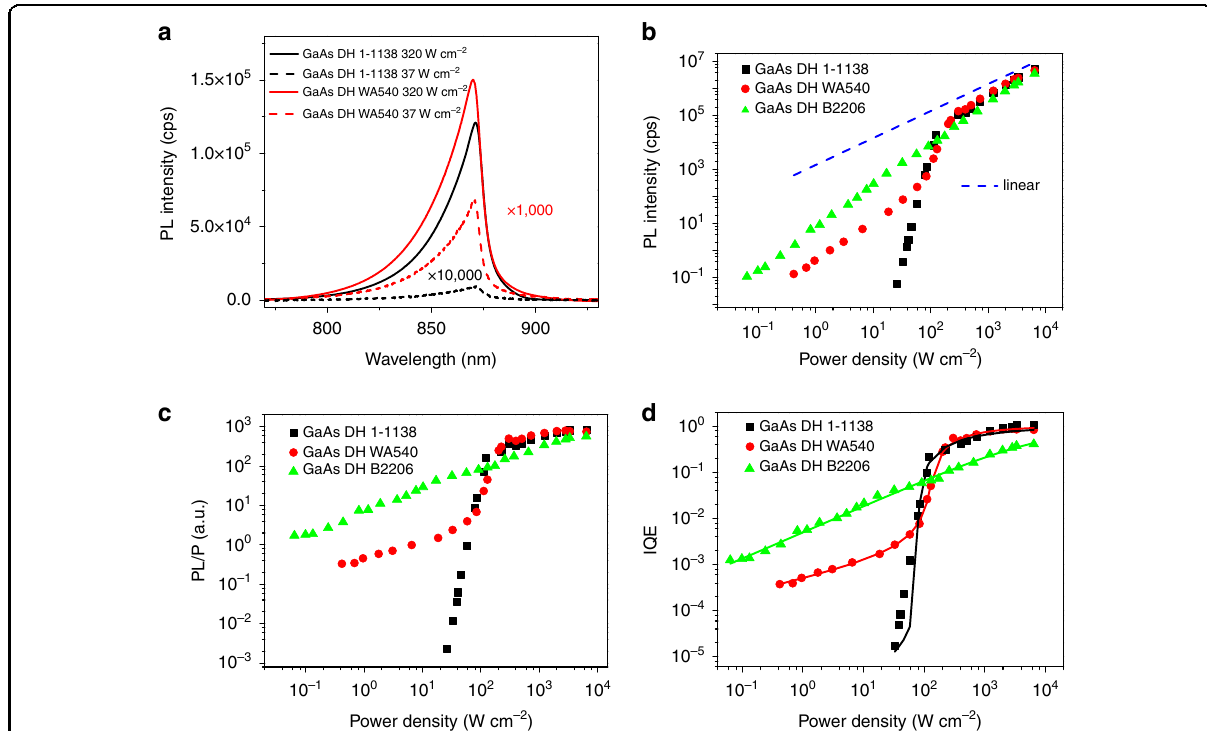
Fig. 2 Excitation power dependent PL data (with 10× lens). a Typical PL spectra of 1-1138 and WA540 at two power densities; b – d PL intensity vs. power density ( P ); PL/ P vs. P ; and IQE vs. P for all three samples. Solid dots are experimental data; solid lines are fi tting curves with the coupling